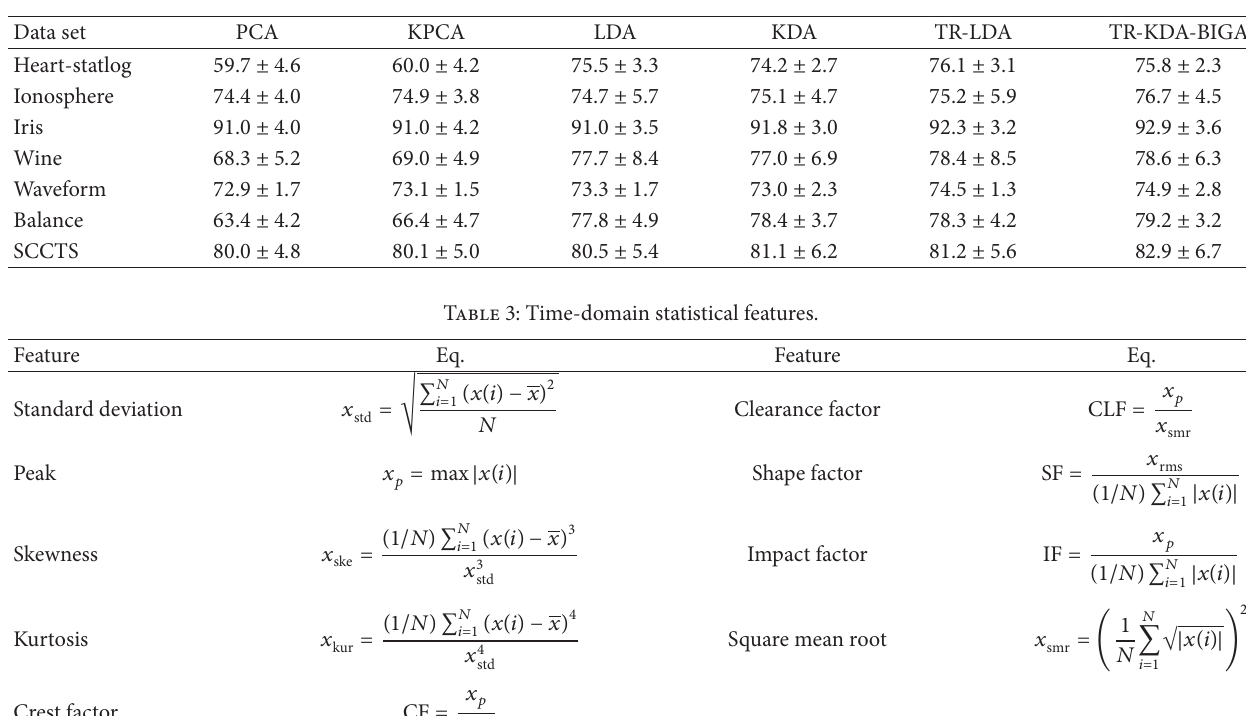
Table 2: Results of the classification rate for the benchmark problems (mean ± derivation).